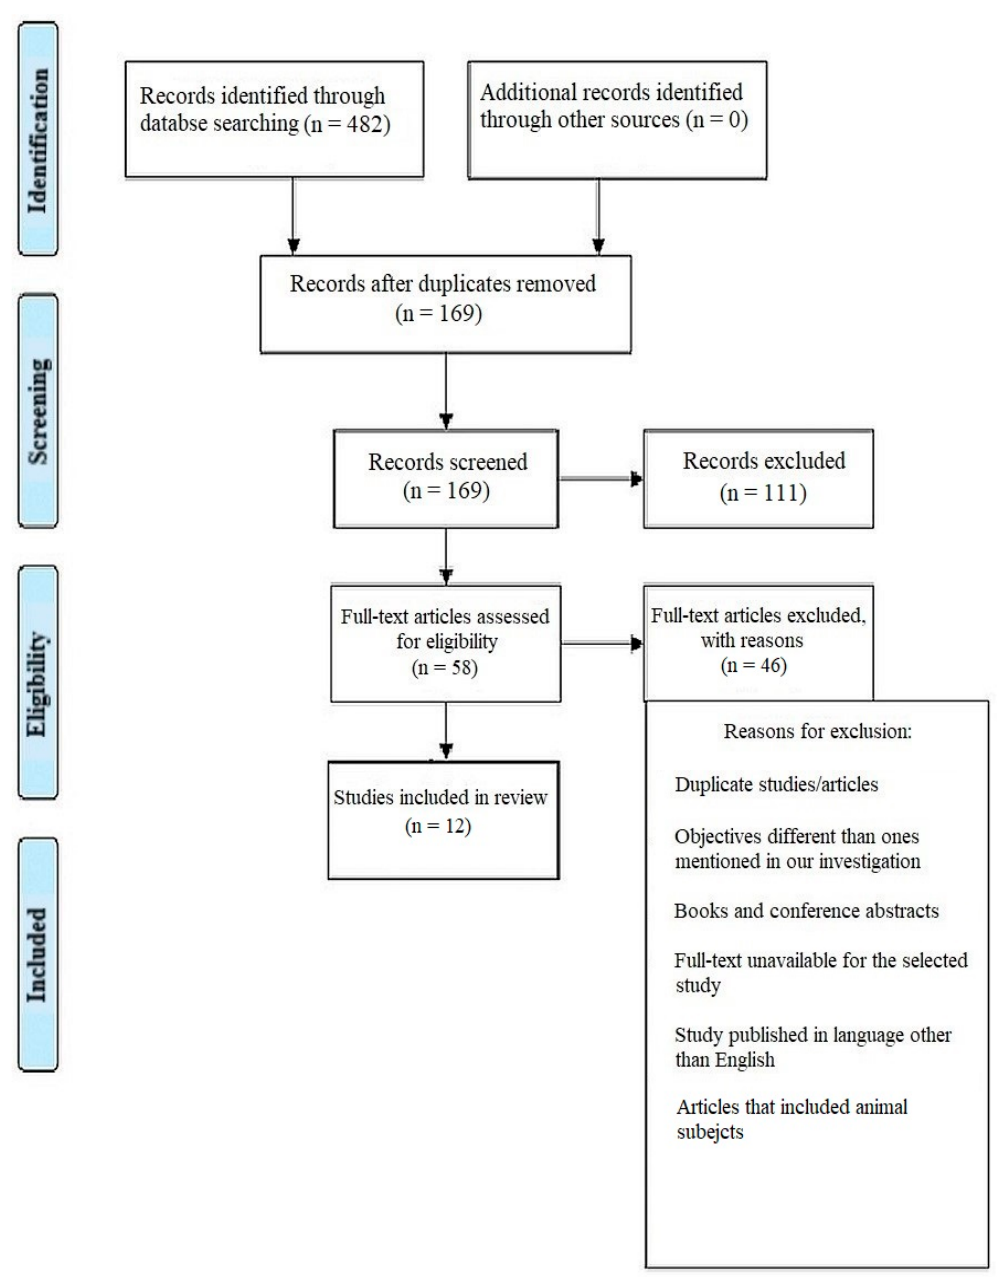
Figure 1. Representation of selection of articles through PRISMA framework.